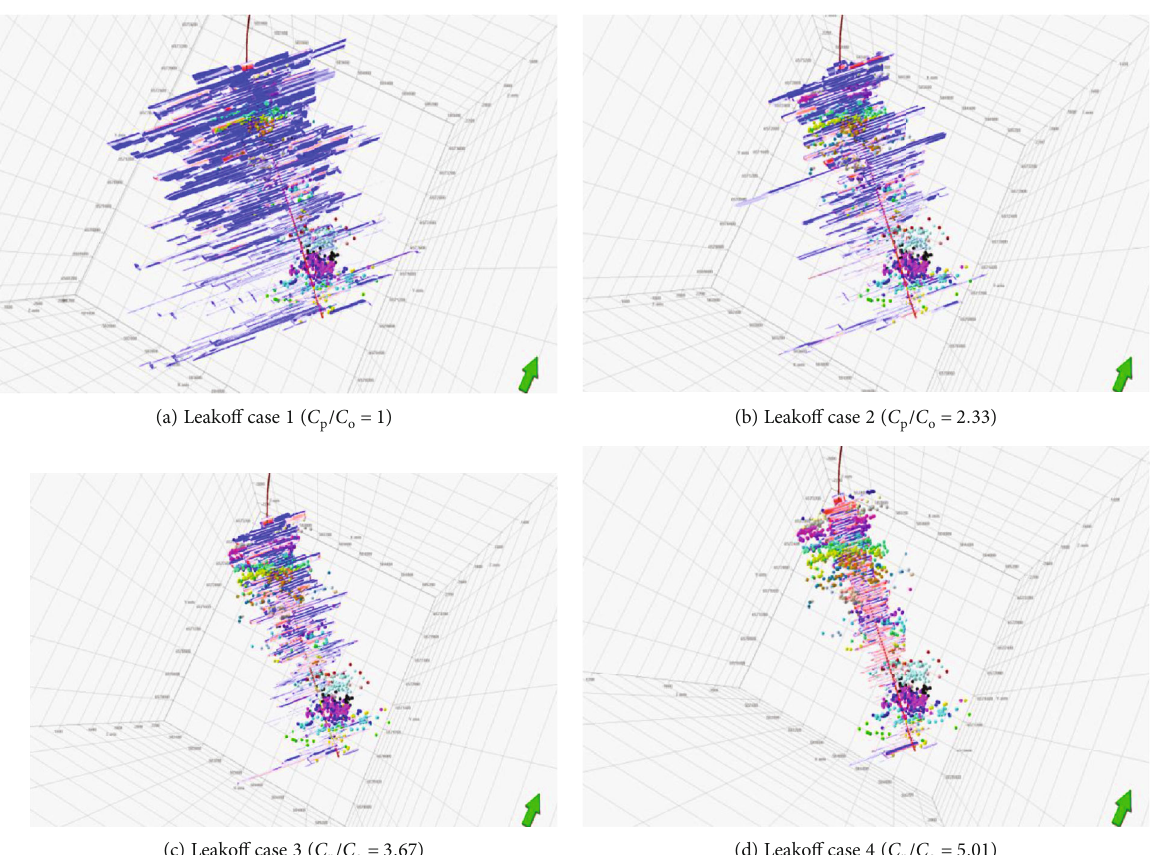
Figure 8: Fracture simulation results of leako ff multiplier cases.